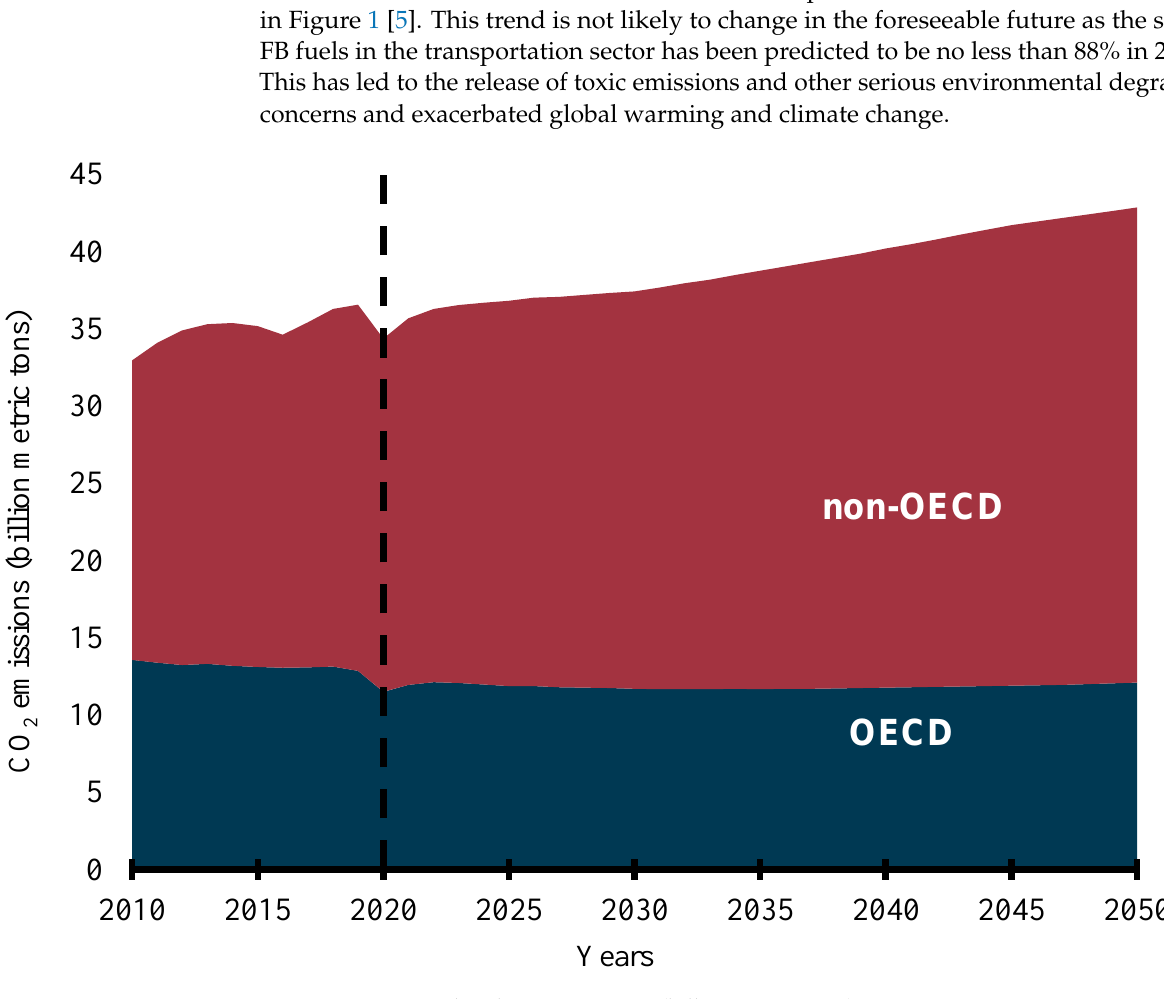
Figure 1. Energy-related CO 2 emissions (billion metric tons).